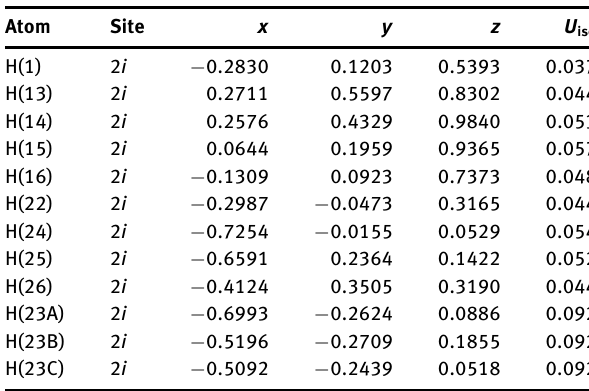
Table 2: Fractional atomic coordinates and isotropic or equivalent